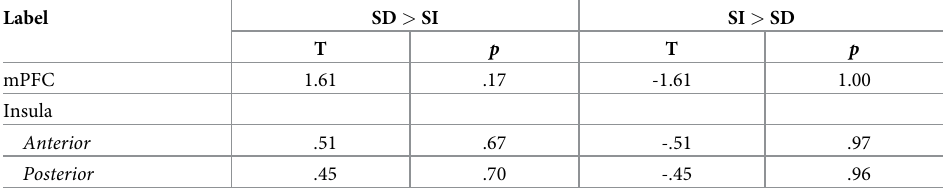
Table 5. Regions of interest analyses comparing activity while adopting a self-distanced vs. self-immersed per- spective when exposed to negative feedback.